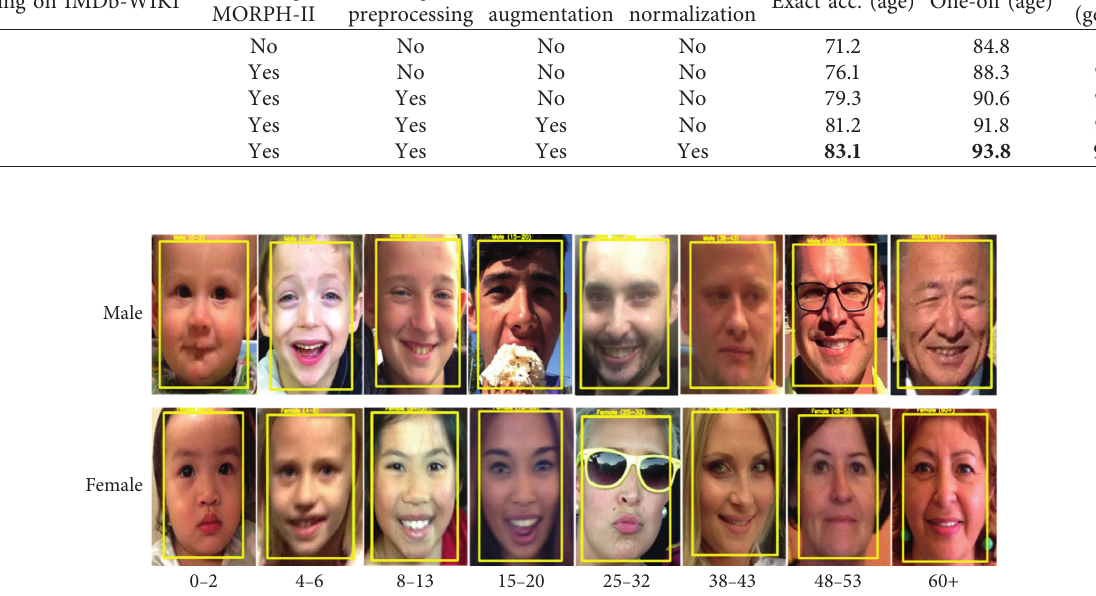
Figure 6: Graphs of cross entropy loss results for the age group and gender classification. (a) Cross entropy loss for age classifier. (b) Cross entropy loss for gender classifier. Table 6: The details of experimental results of our model on OIU-Adience dataset. Fine-tuning on Pretraining on IMDb-WIKI MORPH-II